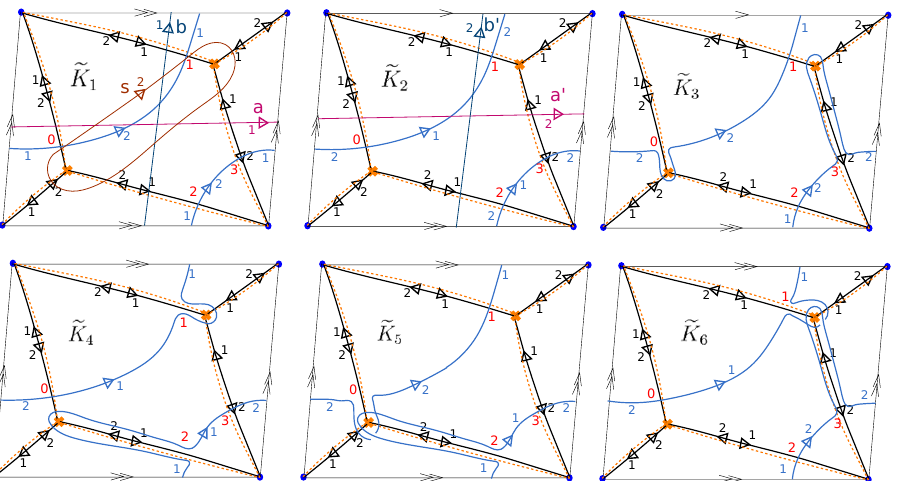
Figure 40 . The six lifts e K i of K . We also show a basis f (cid:13) 1 ; (cid:13) 2 ; (cid:13) 3 ; (cid:13) 4 ; (cid:13) 5 g for H 1 ( e C; Z ) with representatives s; a; b; a 0 ; b 0